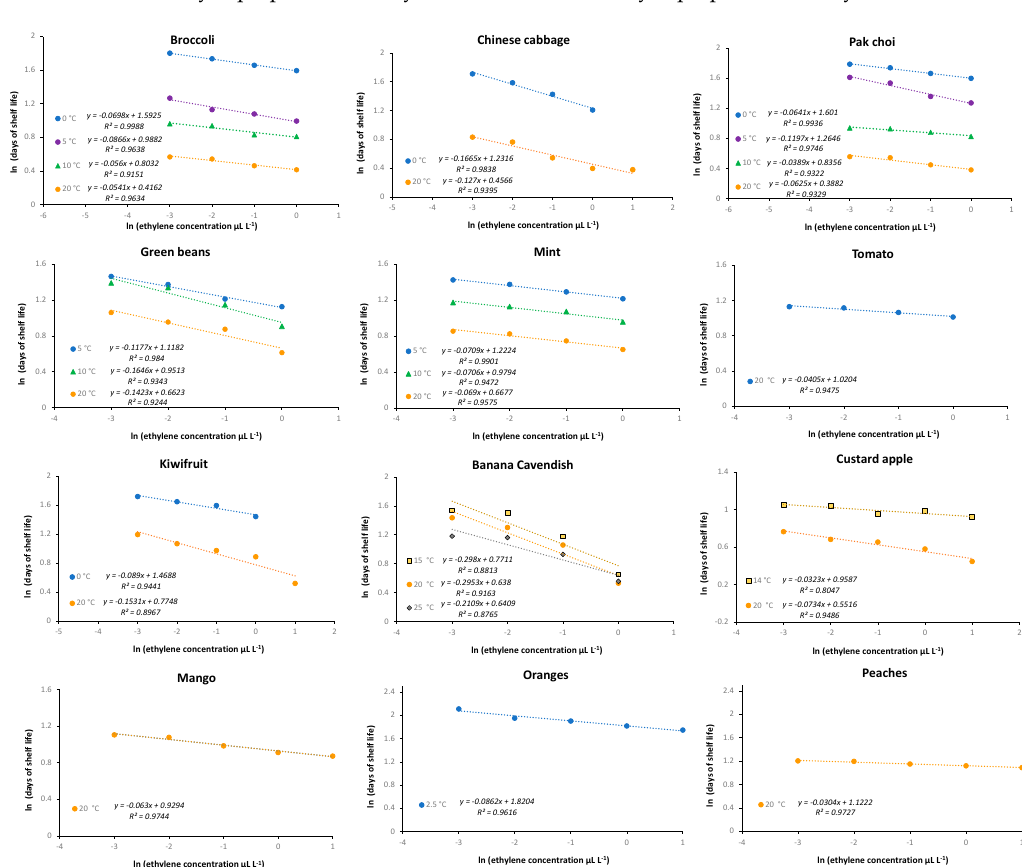
Figure 2. Effect of ethylene concentrations in storage facilities on the shelf life of fruit and vegetables (elaborated from [11–13]). The corresponding equations of linear regression lines and R 2 values are also provided. The threshold atmospheric level below no physiological effects on horticultural pro-